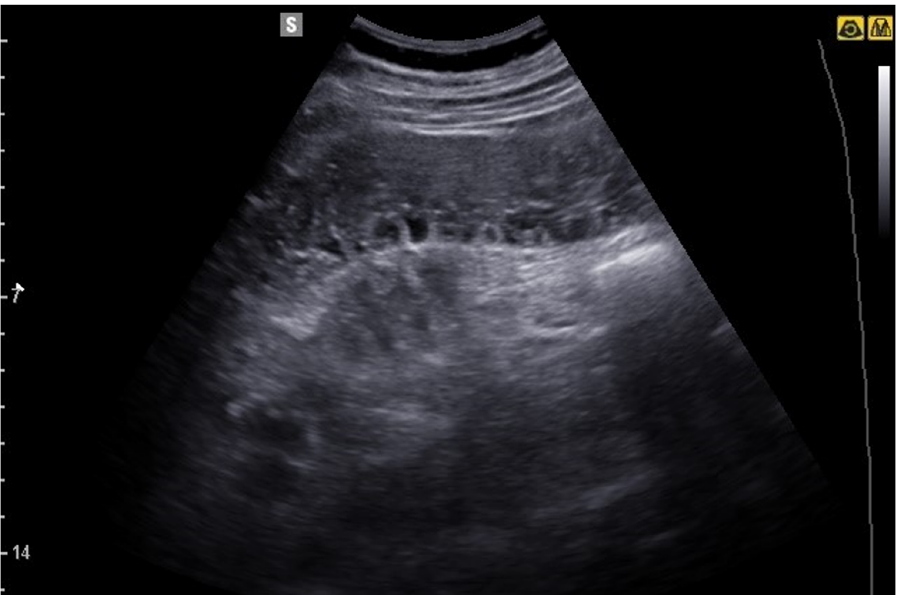
Figure 13. Image obtained with convex probe. Dilated small bowel loops, with evidence of Kerckring valves also called valvulae conniventes (“keyboard sign”), and corpuscular material in ‐ side. In live examination there is a to ‐ and ‐ fro movement. Diagnosis: small bowel obstruction due to